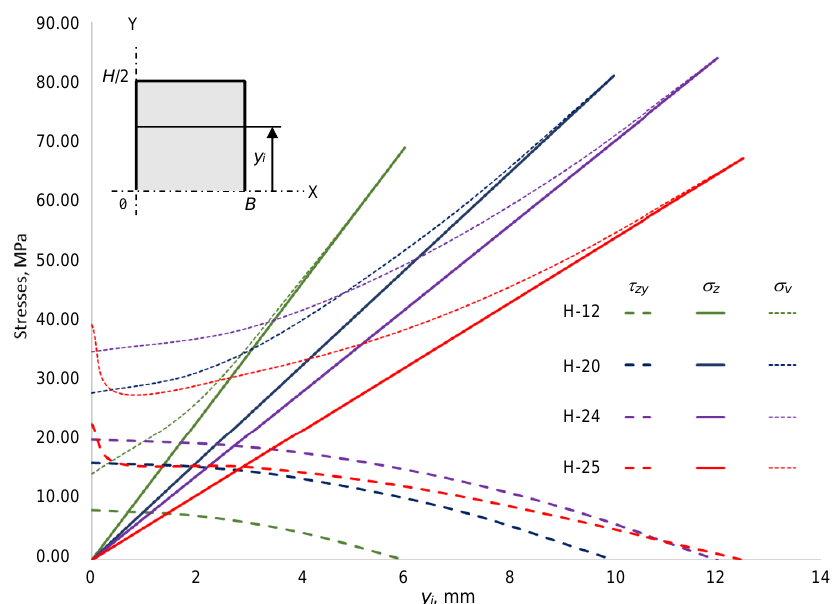
Figure 13. Distribution of stresses at different cross-sectional levels taken along the y -axis.